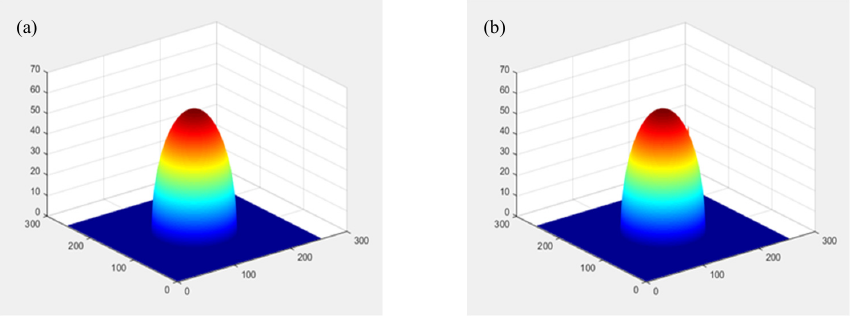
Figure 8. ( a ) The measured three-dimensional object; ( b ) the restored three-dimensional object.